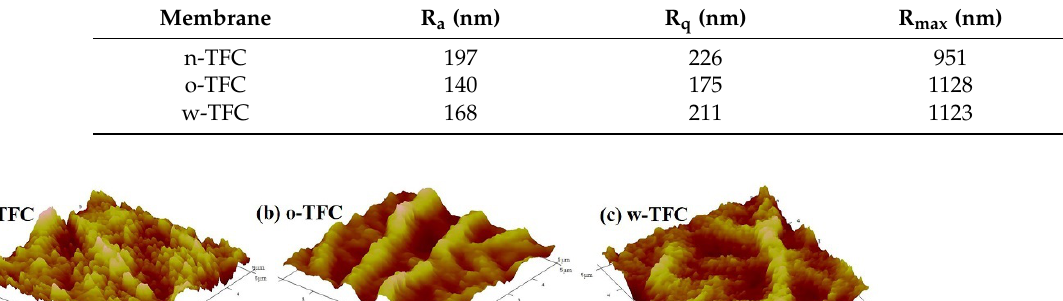
Table 1. Surface roughnesses of the polyamide (PA) active layers of the TFC FO membranes prepared via different heat-curing methods.